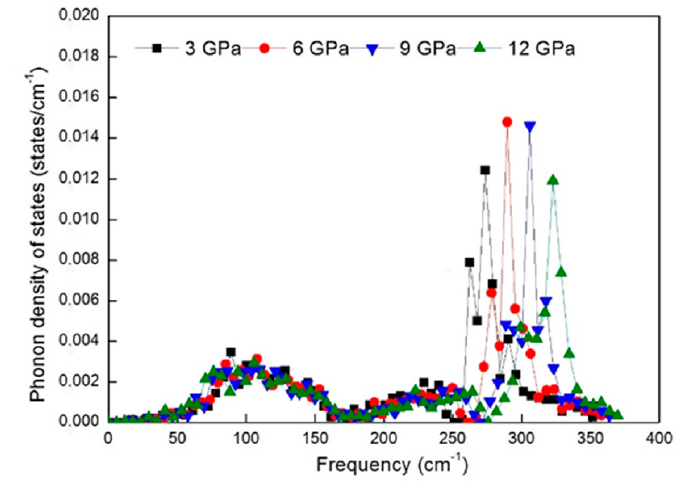
Figure 9. Total phonon density of states of (PDOS) curves of WZ ZnS under zero temperature with pressures 3 GPa, 6 GPa, 9 GPa, and 12 GPa.